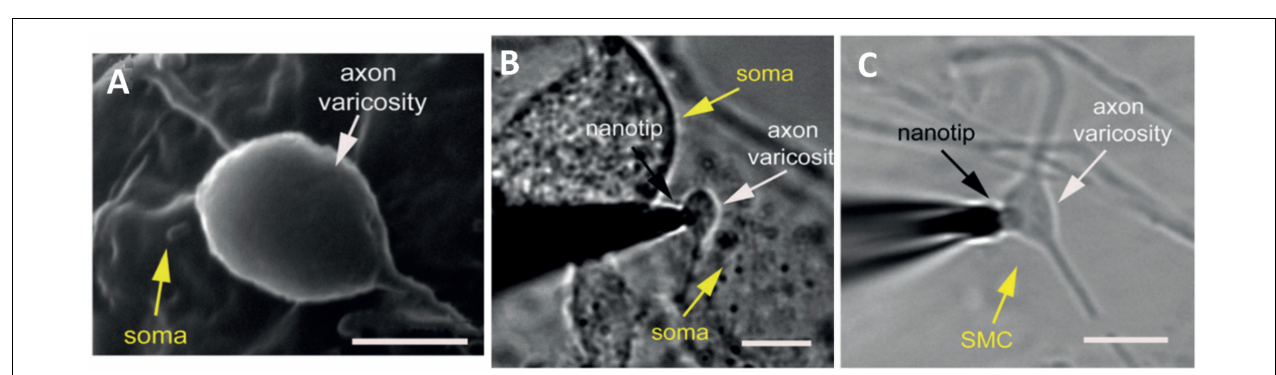
FIGURE 7 | Amperometric measurements of noradrenaline release at single synapses. (A) Scanning electron microscope image of a synapse formed between cultured superior cervical ganglion (SCG) sympathetic neurons. (B) Bright field photomicrograph of the nanotip at an individual synapse, between a varicosity of one SGC neuron and the soma of another neuron. (C) Photomicrograph of the nanotip electrode at a synapse, between a varicosity of a SGC neuron and smooth muscle cell. These Figures were reproduced from Li et al. (2014) under the creative commons